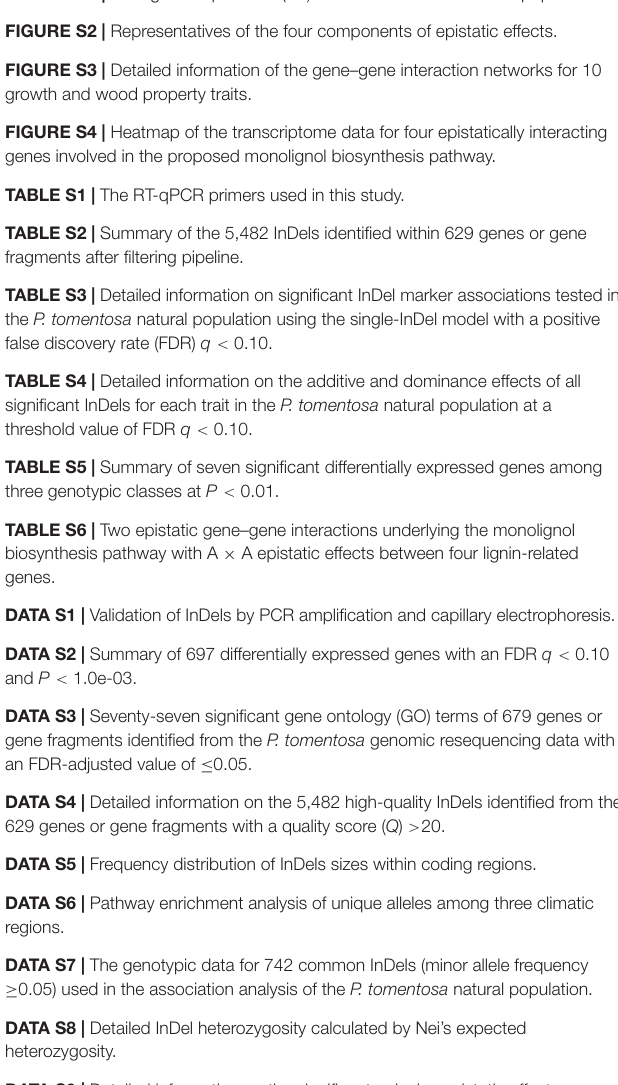
FIGURE S1 | Linkage disequilibrium (LD) in the P. tomentosa natural population. FIGURE S2 | Representatives of the four components of epistatic effects. FIGURE S3 | Detailed information of the gene–gene interaction networks for 10 growth and wood property traits. FIGURE S4 | Heatmap of the transcriptome data for four epistatically interacting genes involved in the proposed monolignol biosynthesis pathway. TABLE S1 | The RT-qPCR primers used in this study. TABLE S2 | Summary of the 5,482 InDels identified within 629 genes or gene fragments after filtering pipeline. TABLE S3 | Detailed information on significant InDel marker associations tested in the P. tomentosa natural population using the single-InDel model with a positive false discovery rate (FDR) q < 0.10. TABLE S4 | Detailed information on the additive and dominance effects of all significant InDels for each trait in the P. tomentosa natural population at a threshold value of FDR q < 0.10. TABLE S5 | Summary of seven significant differentially expressed genes among three genotypic classes at P < 0.01. TABLE S6 | Two epistatic gene–gene interactions underlying the monolignol biosynthesis pathway with A × A epistatic effects between four lignin-related